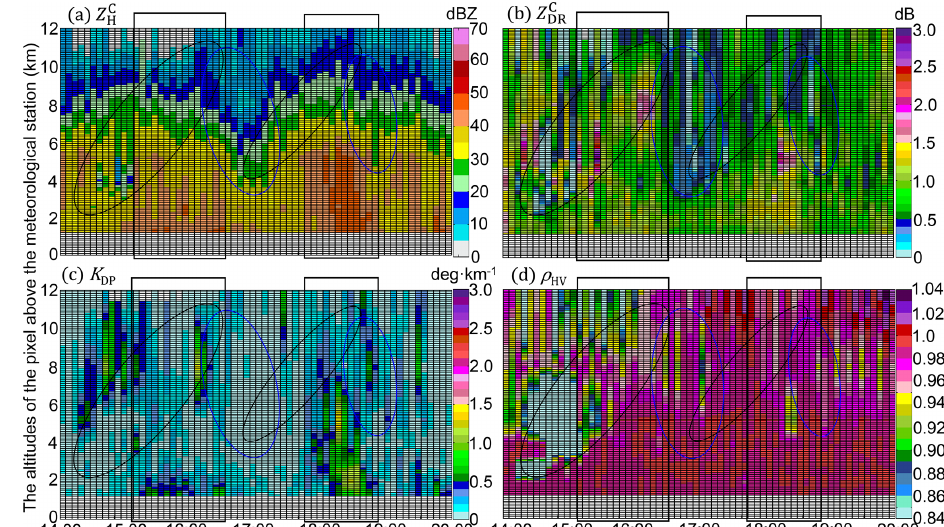
Figure 15. The same as Fig. 12 but for the DT